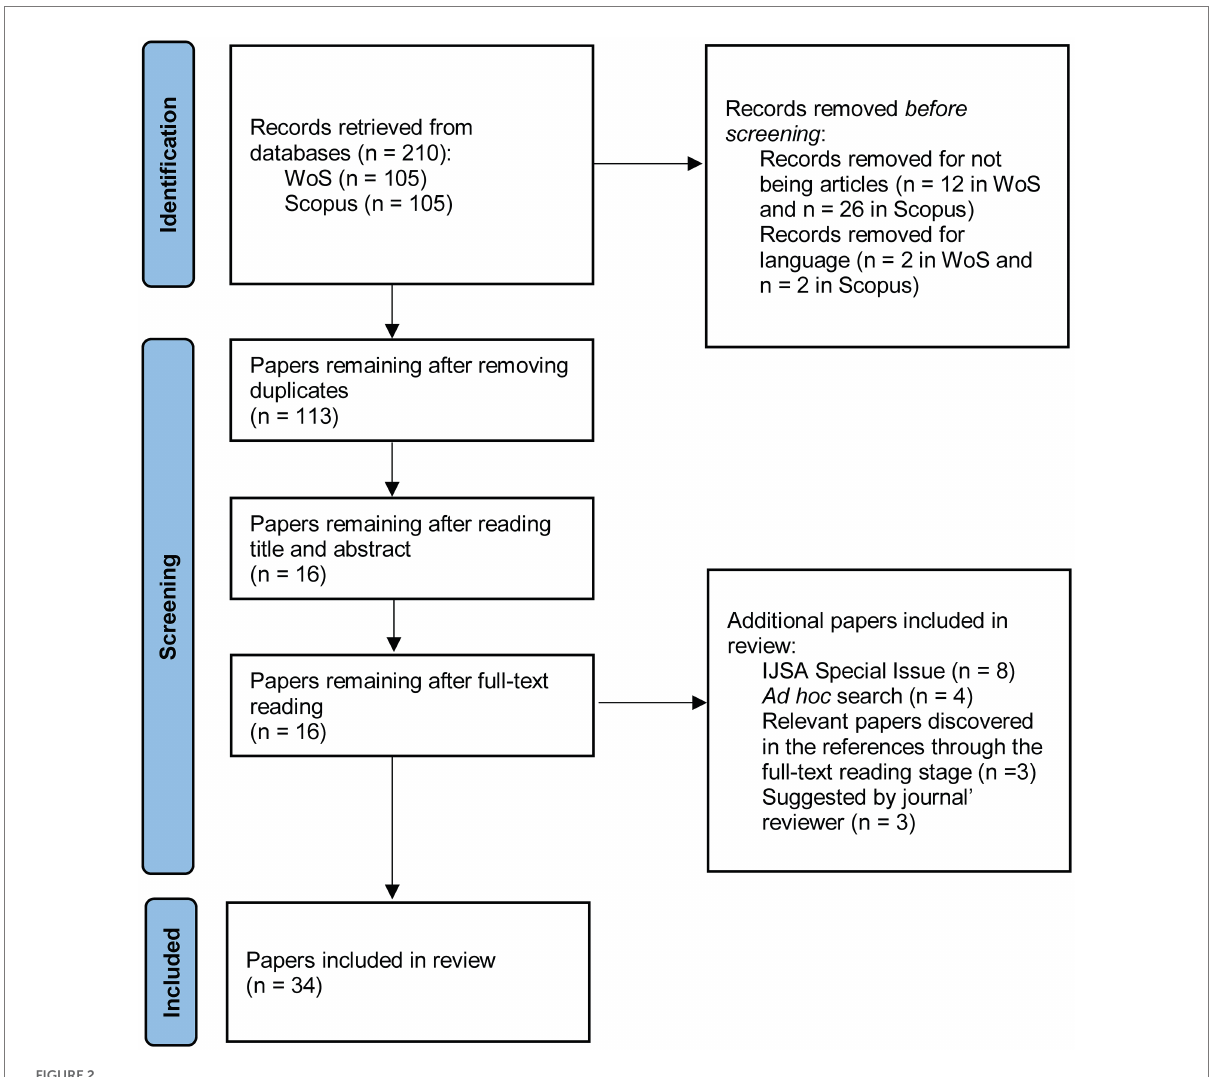
FIGURE 2 PRISMA flow diagram for the systematic